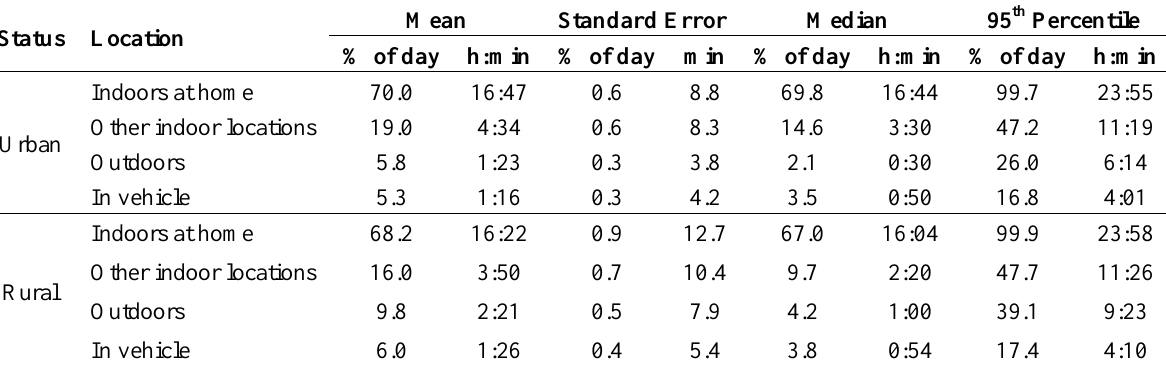
Table 7. Daily time spent in major locations for the population by urban-rural